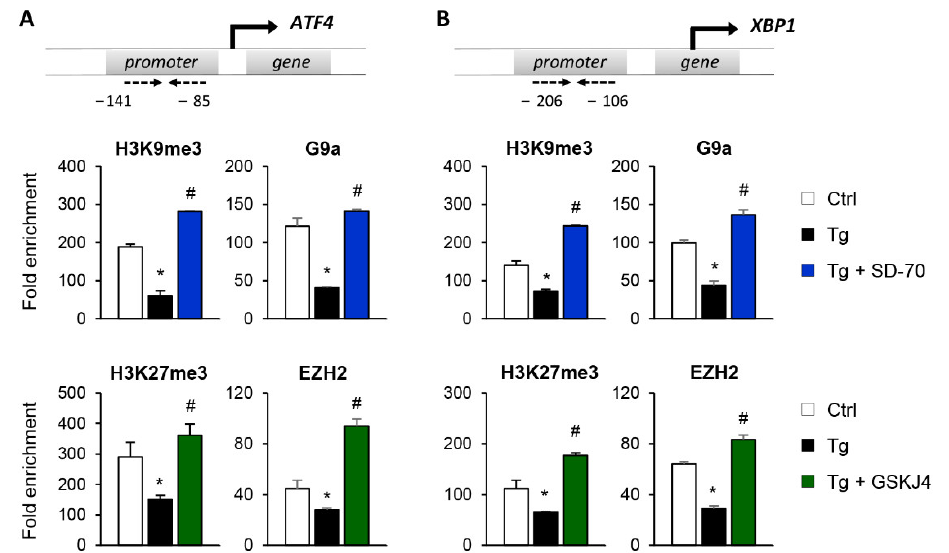
Figure 8. Inhibition of the KDM4C and JMJD3 histone demethylases restores the epigenetic changes induced by UPR activation. HK-2 cells were treated with SD-70 (KDM4C inhibitor, 20 µ M, 24 h) or GSKJ4 (JMJD3 inhibitor, 15 µ M, 24 h) in the presence of thapsigargin (Tg, 4 µ M, 24 h). Treatment with DMSO and Tg were used as negative and positive controls. ChIP assays were performed using specific antibodies against H3K9me3,H3K27me3, G9a, and EZH2. Enrichment in the promoter region of ATF4 ( A ) and XBP1 ( B ) genes were determined by quantitative RT-PCR using specific primers (dashed arrows). Data are presented as the mean ± SEM of two or three independent experiments and each RT-PCR was run in triplicate. Results are represented as the fold enrichment of each specific antibody relative to a negative control (normal rabbit IgG). * p < 0.05 vs. control and # p < 0.05 vs. cells treated with Tg.